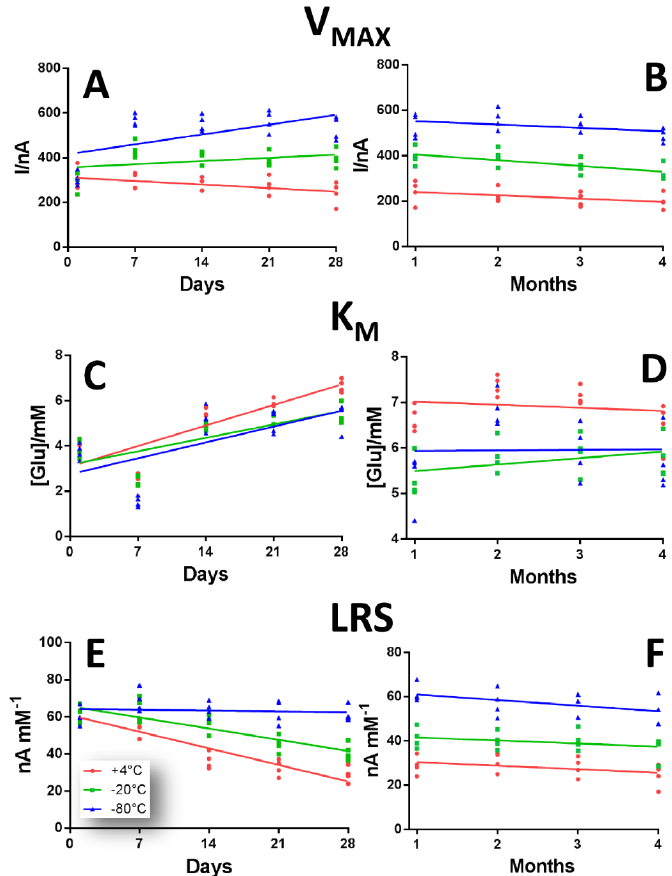
Figure 2. Scattering plot describing the variations of V MAX (Panel A and B), K M (Panel C and D) and LRS (Panel E and F), in a range of 28 days (left inset) and of four months (right inset) of GB1 design Pt c /PPD/[PEI (0.5%)-GOx] 5 /PU (5%) when stored at +4 °C (red plot), − 20 °C (green plot) and − 80 °C (blue plot).